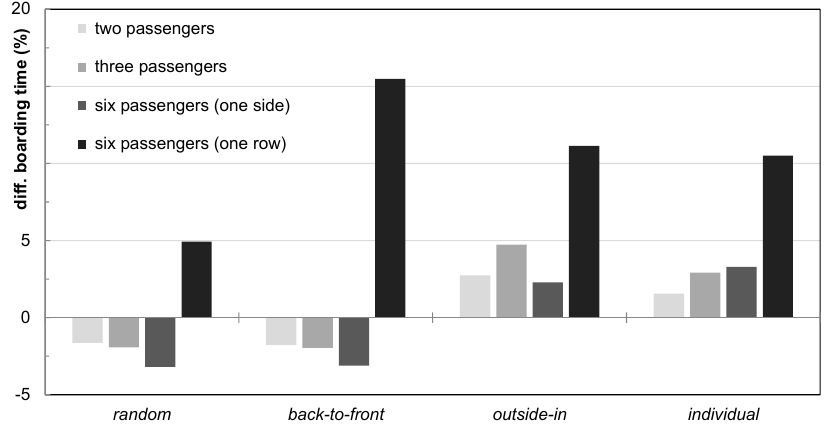
Figure 13. Boarding time difference considering four exemplary group constellations.